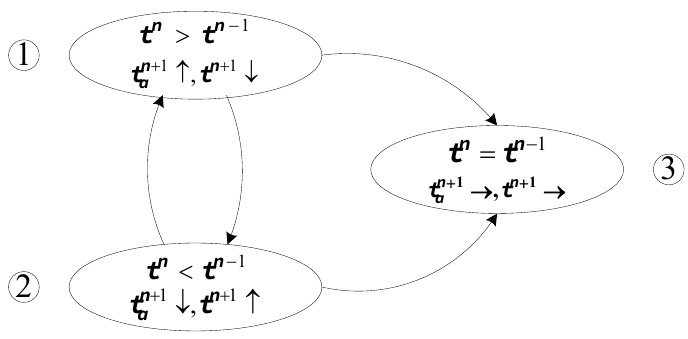
Figure 9. State transition diagram of SP of a